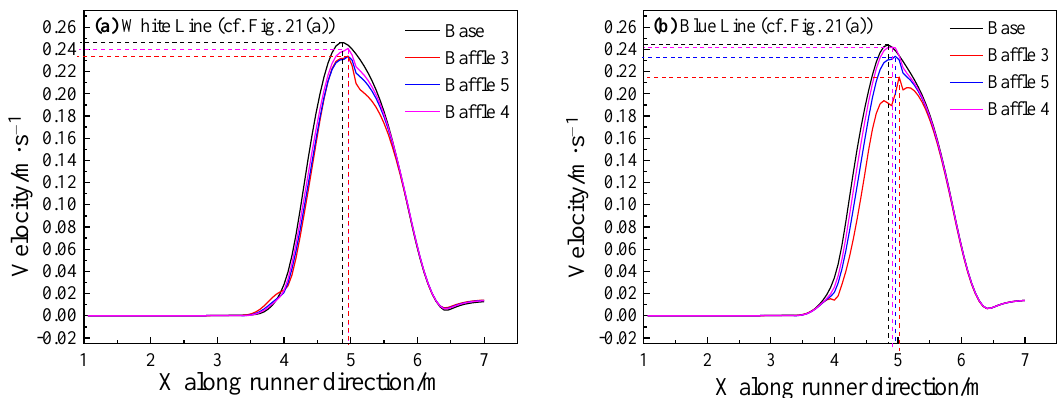
Figure 21. Velocity distribution of different main troughs with different widths near the wall at two lines: ( a ) White Line; ( b ) Blue Line.